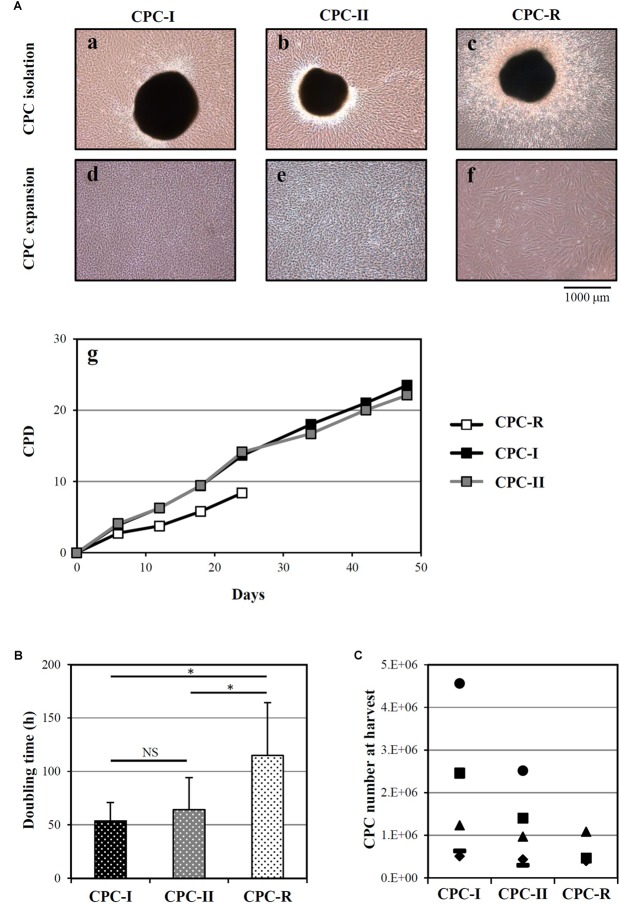
Isolation and culture of CPC. (A) Representative images of CPC outgrowth from cardiac fragments (a–c) and CPC expansion (d–f), under the GMP grade methods I and II (CPC-I and -II) and the research grade method (CPC-R). The cumulative population doublings (CPD) over time is also shown (g) for the same representative experiment. (B) Doubling times (mean + SD, n = 5) of CPC cultured in the different conditions. NS, not significant; ∗p < 0.05, one-way ANOVA with Student’s t-test with Bonferroni correction. (C) CPC number at harvest from the outgrowth plates, by culture conditions. CPC-I and -II: n = 5; CPC-R: n = 3.